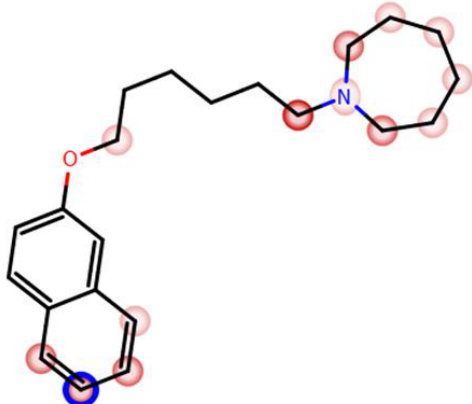
Figure 5. Potential sites of metabolism for H3R antagonist 4 . The blue circle marks the site involved in metabolism with the highest probability. Other potential sites are marked with red color; the darker the color, the higher the probability of involvement in the metabolism pathway (calculated with MetaSite [53]).